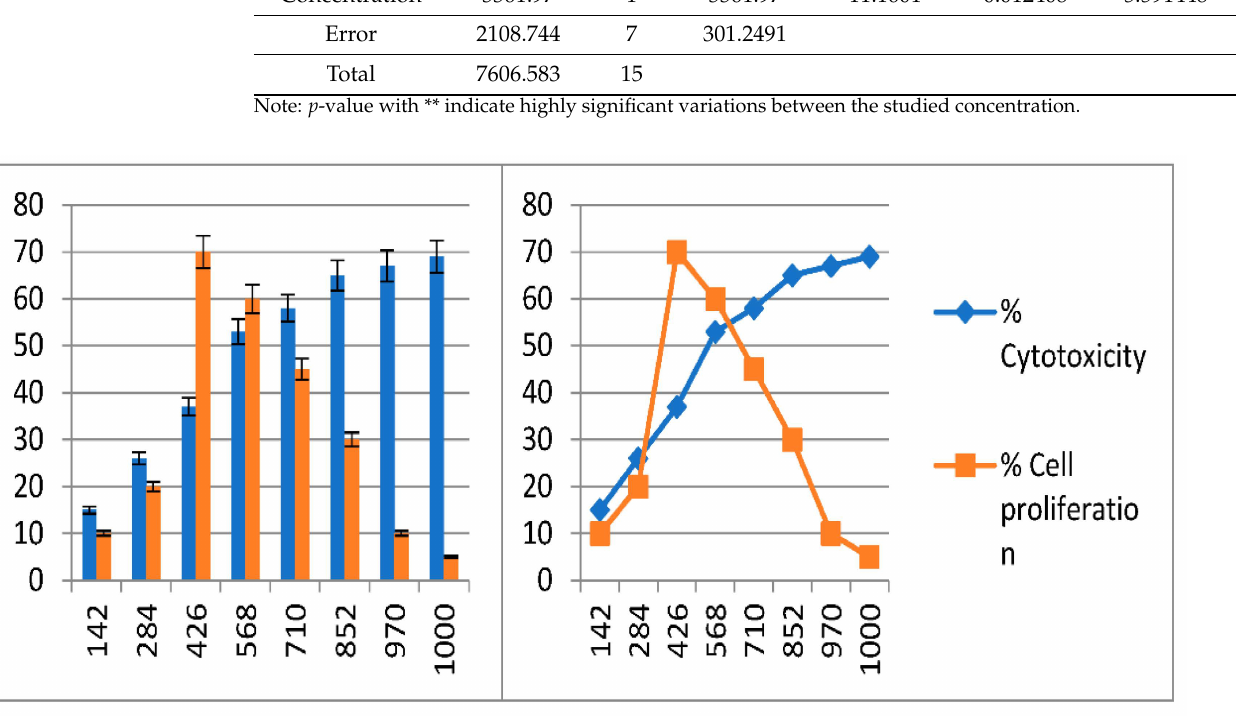
Figure 9. Comparison of cytotoxicity and cell proliferation ( n = 5) level against various nanoparticle concentrations on cell